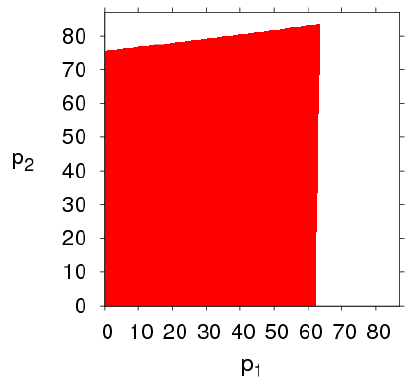
Figure 18. Basins of attraction of dynamic system (6), α 1 = α 2 = 0.005, λ 2 = 0.8.